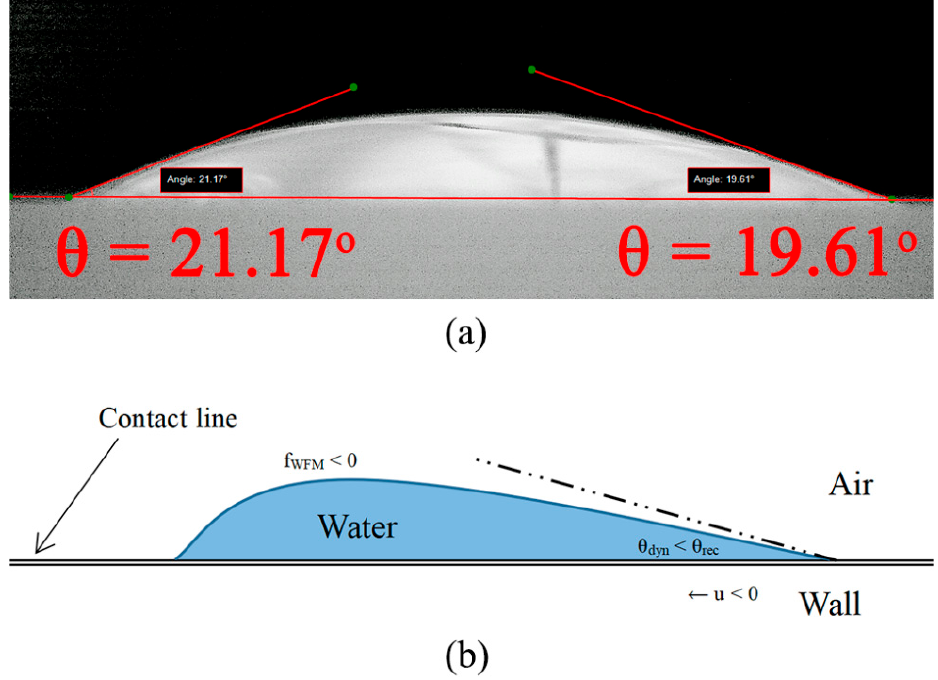
Figure 4. Receding and Dynamic Contact Angle for Hydrophilic Surface: ( a ) Experimental Record Contact Angle; ( b ) Schematic Diagram of Contact Angle Concept in Simulation Model.